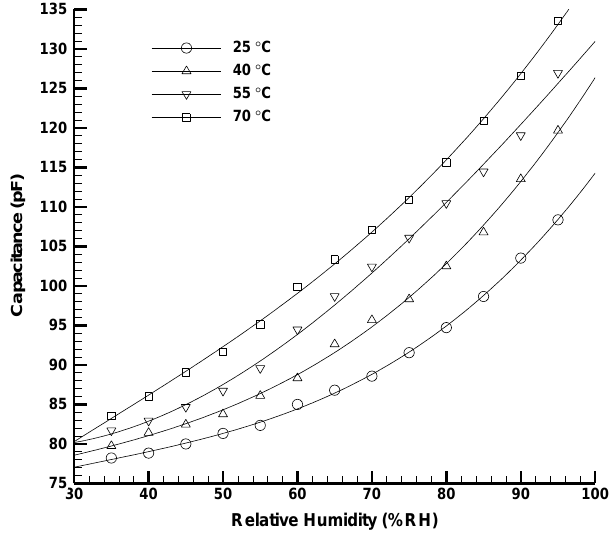
Figure 4. Capacitive humidity microsensor performances at different temperatures in an environmental chamber.